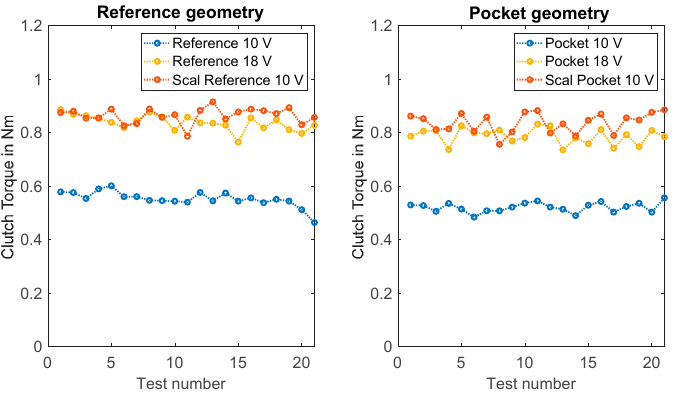
Figure 13. Comparison of clutch torques between reference and pocket geometry at measuring shaft 2.